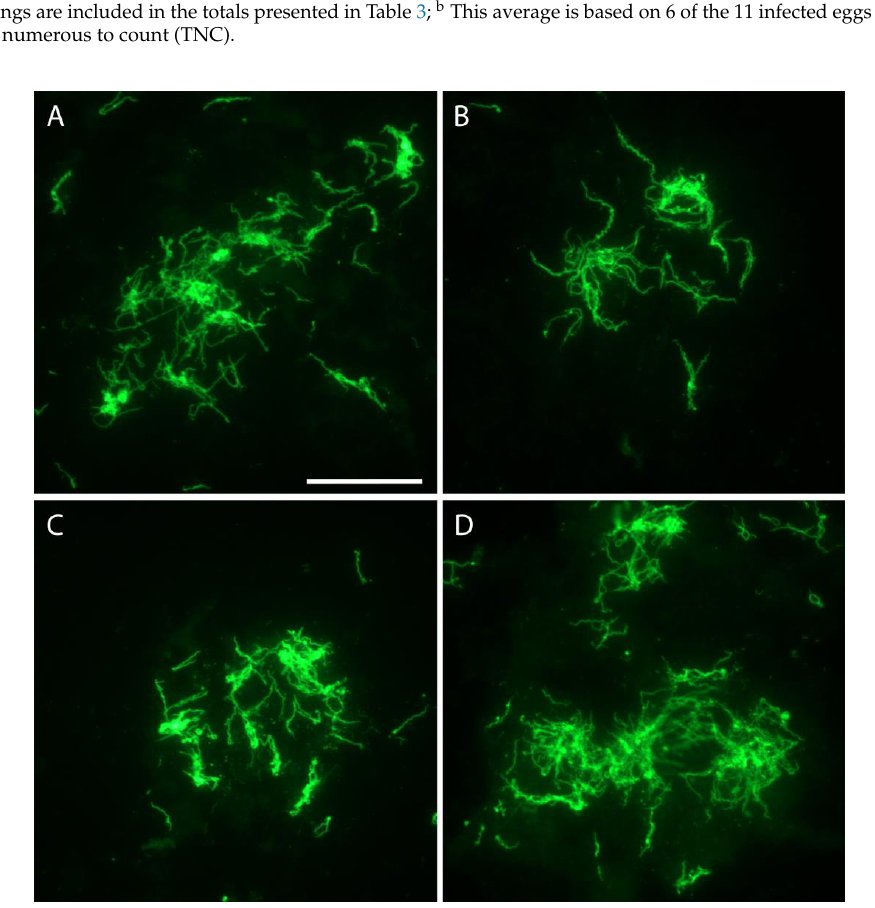
Figure 4. Borrelia hermsii in an O. hermsi egg stained with anti- B. hermsii rabbit hyperimmune serum and goat anti-rabbit FITC ( A ) and stained again with the anti-Vtp mouse monoclonal antibody and goat anti-mouse RITC ( B ). Scale bar = 40 µm. 3.7. Microscopic Examination of Unfed Larvae Because spirochetes in eggs produced Vtp (Figure 4B), immunofluorescent staining with the anti-Vtp antibody was used to visualize B. hermsii in unfed larvae produced by five infected females (Table 6). Infected larvae were found in all 5 cohorts, and in total 33